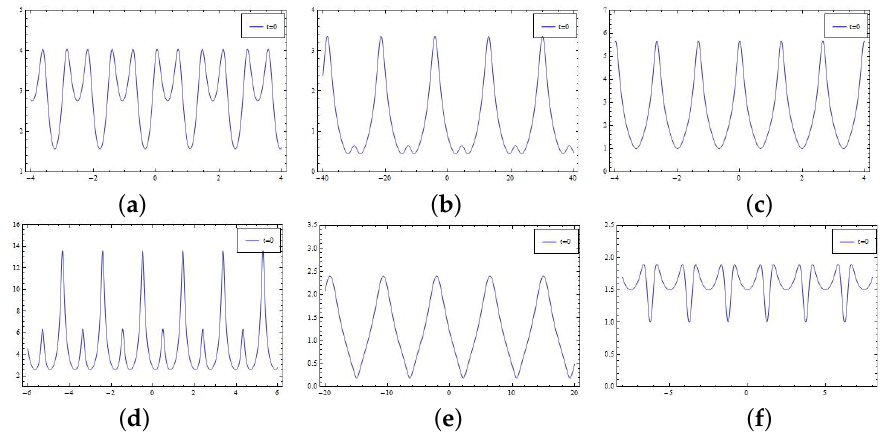
. For the focusing case with 5